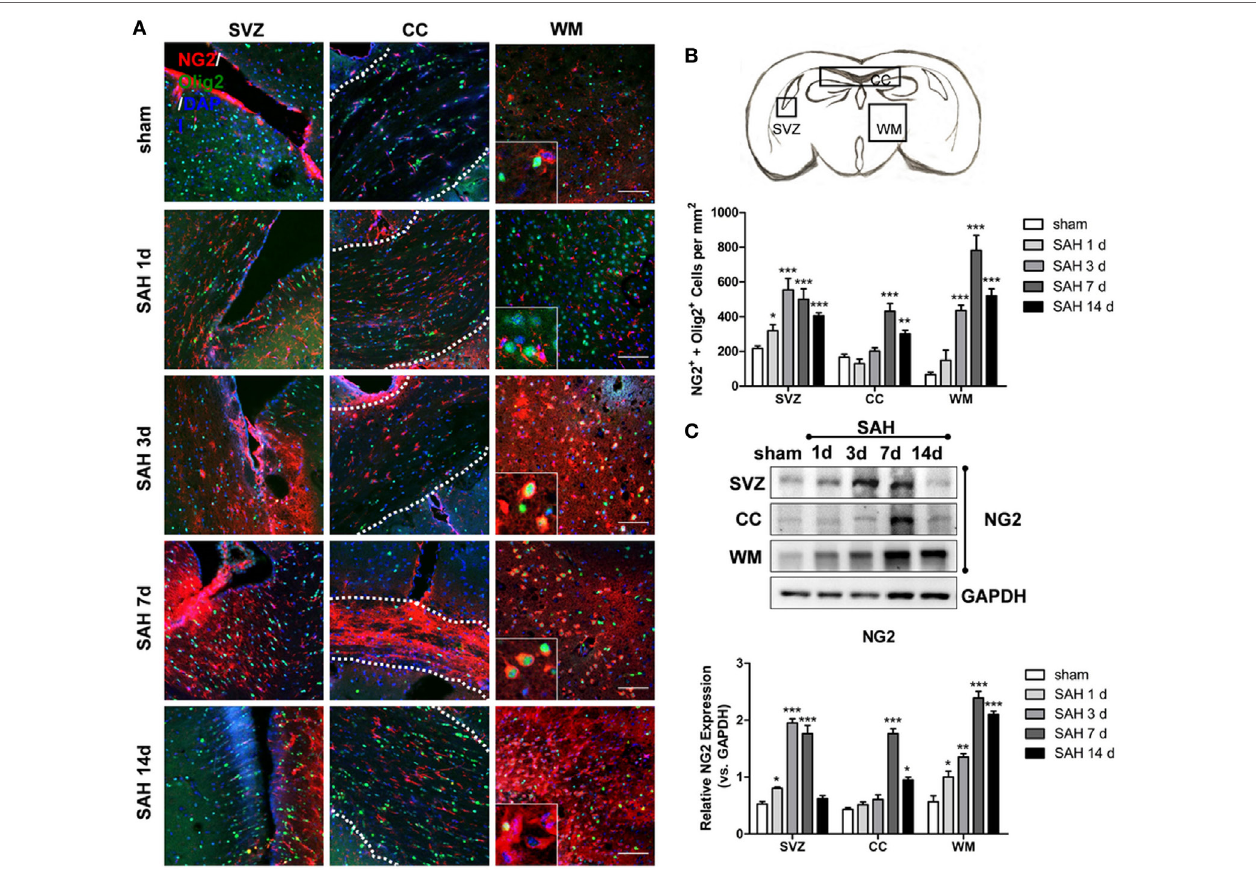
FigUre 1 | Oligodendrocyte progenitor cell proliferation and migration to WM after SAH. (a) Representative images of NG2- and Olig2-positive cells (20 × ) are shown. Scale bar = 50 µm. The anatomy drawing in the upper right corner indicates the relative areas. (B) Statistics of double-positive NG2 and Olig2 cells in the SVZ, CC, and WM of mouse brains at 1, 3, 7, and 14 days after SAH. (c) Western blot analysis of NG2 and GAPDH in distinct areas of the SVZ, CC, and WM at 1, 3, 7, and 14 days after SAH. The data are presented as the mean ± SEM, n = 6 for each group. * P < 0.05 versus the sham group, ** P < 0.01 versus the sham group, *** P < 0.001 versus the sham group. SVZ, subventricular zone; CC, corpus callosum; WM, white matter; SAH, subarachnoid